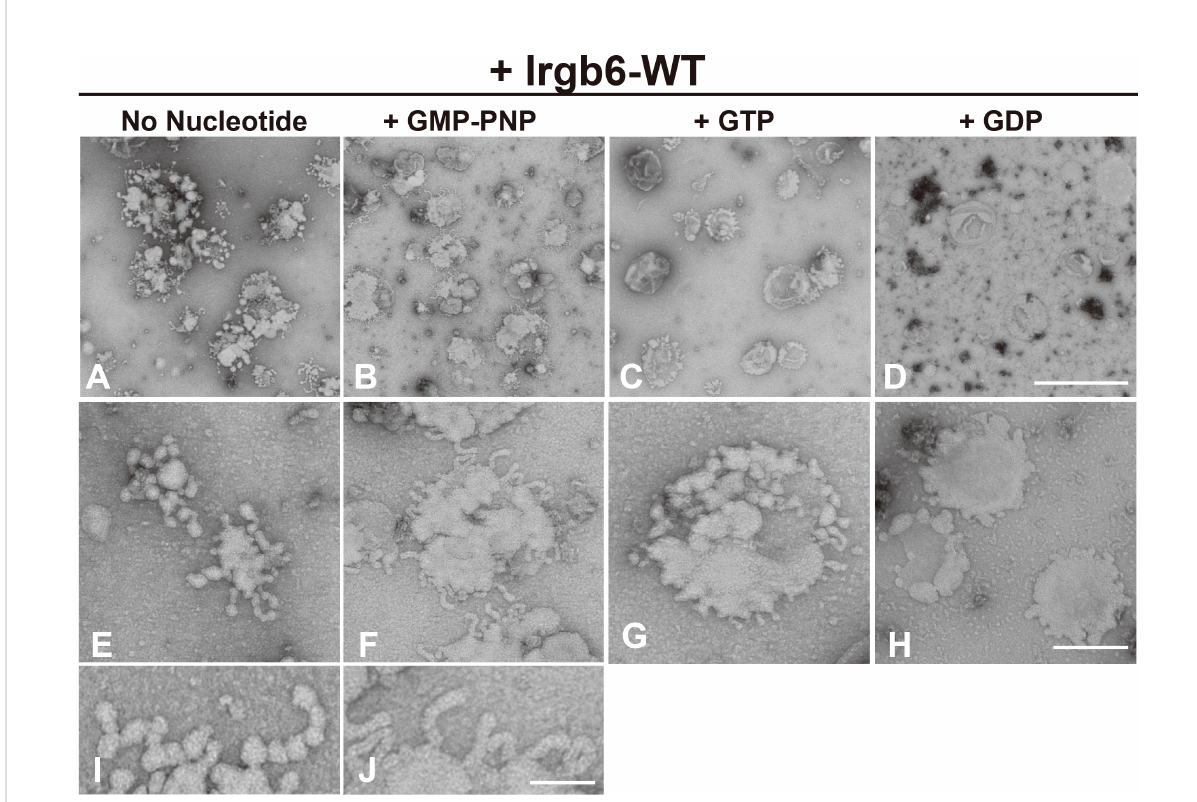
FIGURE 2 Effect of nucleotide on membrane deformation of Irgb6-WT. Negative stain EM showing deformation of PI5P-containing liposomes by Irgb6-WT under nucleotide conditions as indicated. PI5P-containing liposomes (0.1 mg/ml) incubated 1 m M Irgb6-WT as in Figure 1 were absorbed on the grids. Then, buffer alone (A, E, I) , GMP-PNP at 0.5 mM (B, F, J) , GTP at 0.1 mM (C, G) or GDP at 0.1 mM (D, H) was added and incubated for 5 min as is in Supplemental Figure 1. Scale bar: 1000 nm for upper panels (A – D) , 200 nm for middle panels (E – H) , 75 nm in bottom panels (I , J)